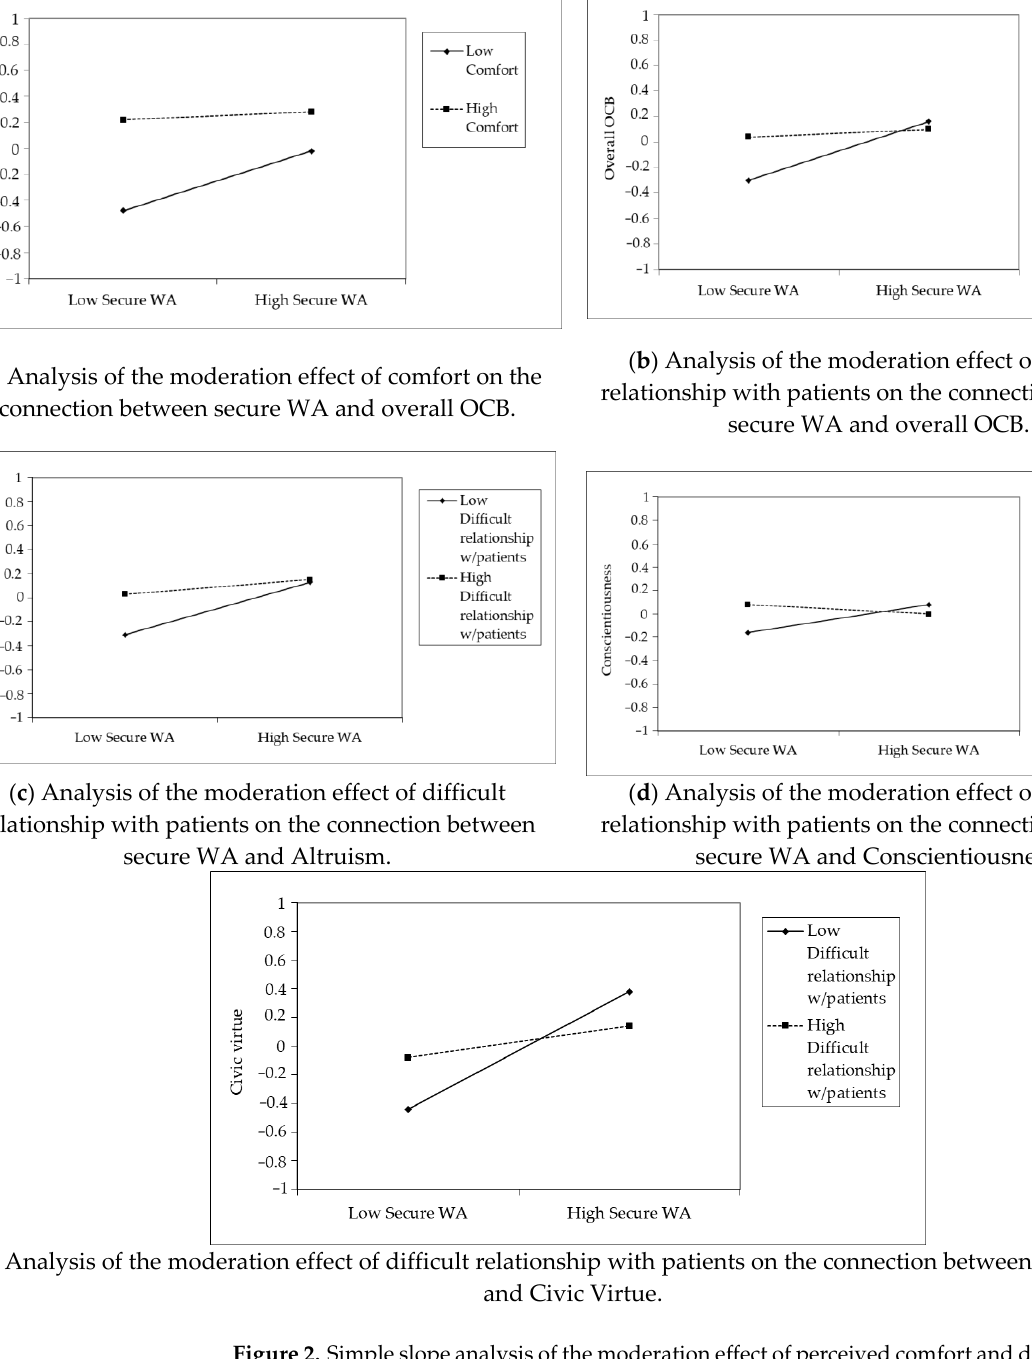
Figure 2. Simple slope analysis of the moderation effect of perceived comfort and difficult relationship with patients, on the connection between secure WA and OCBs (Overall, Altruism, Conscientiousness, and Civic Virtue).